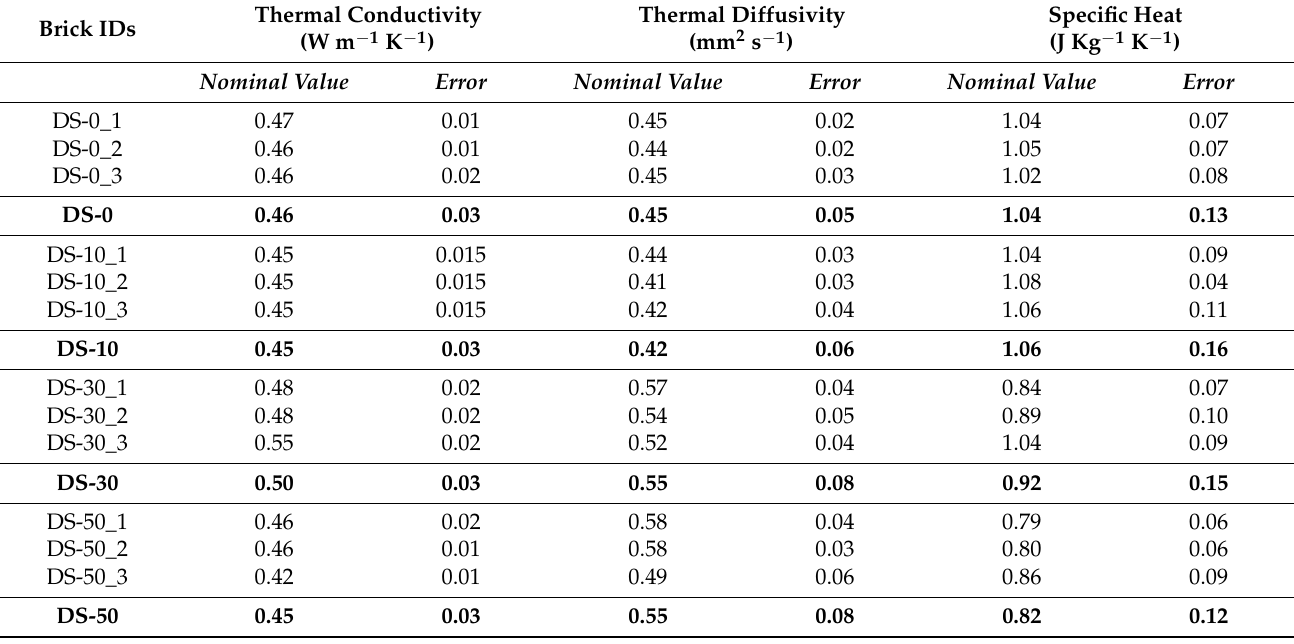
Table 6. Overview of the thermal properties (with the corresponding errors) estimated for brick specimens (three samples for each brick specimen) through the hot disk